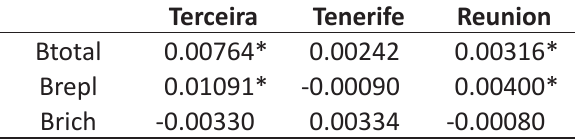
Table 4. Distance decay slopes and respective P values (* P < 0.05) per